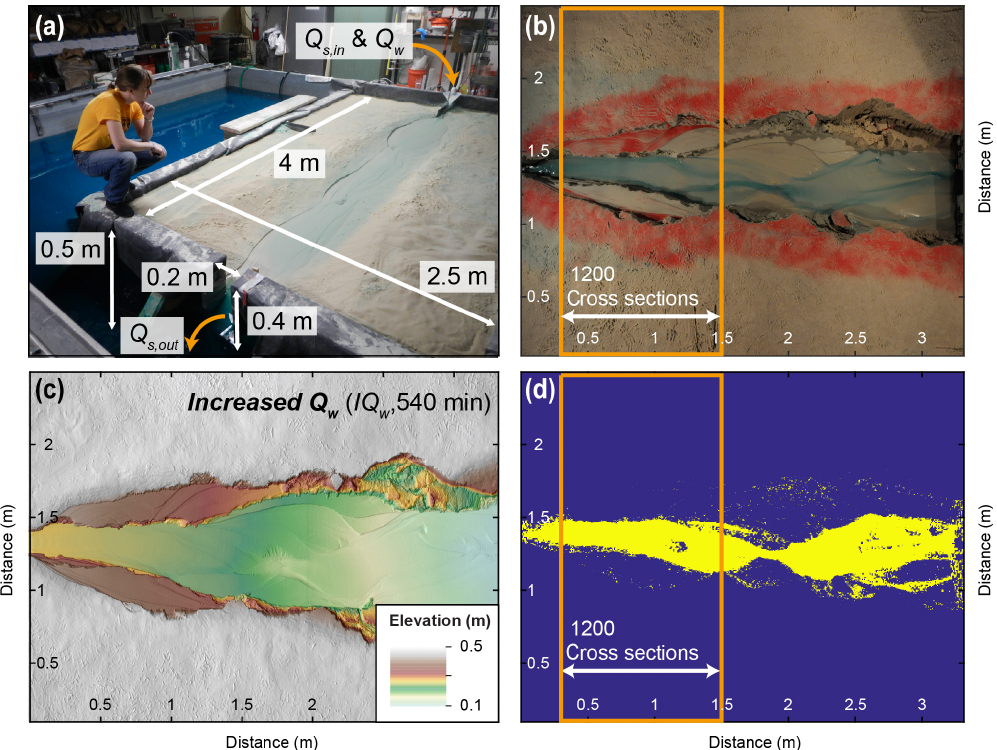
Figure 2. Experimental setup, data collection, and analyses. (a) Overview of experimental setup. Sediment supply ( Q s , in ) and water dis- charge ( Q w ) can be regulated separately. For all but the base-level fall (BLF) experiment, the base level was fixed. Water and sediment fell off of an edge at the outlet. For the BLF experiment (shown in the picture), the base level was controlled through the water level in the surrounding basin. (b) Overhead photograph of the IQ w experiment taken directly before the scan shown in panel (c) . (c) Digital elevation model (DEM) derived from laser scans showing the final topography of the increased water (IQ w ) experiment. The surface was covered with a thin layer of red sand before the instant increase in Q w was performed. The remnants of red sand on the terraces indicate no further reworking after the onset of increased discharge. (d) Overhead photographs were turned into binary (wet, dry) images from which the average channel width within the indicated area (orange frame) was